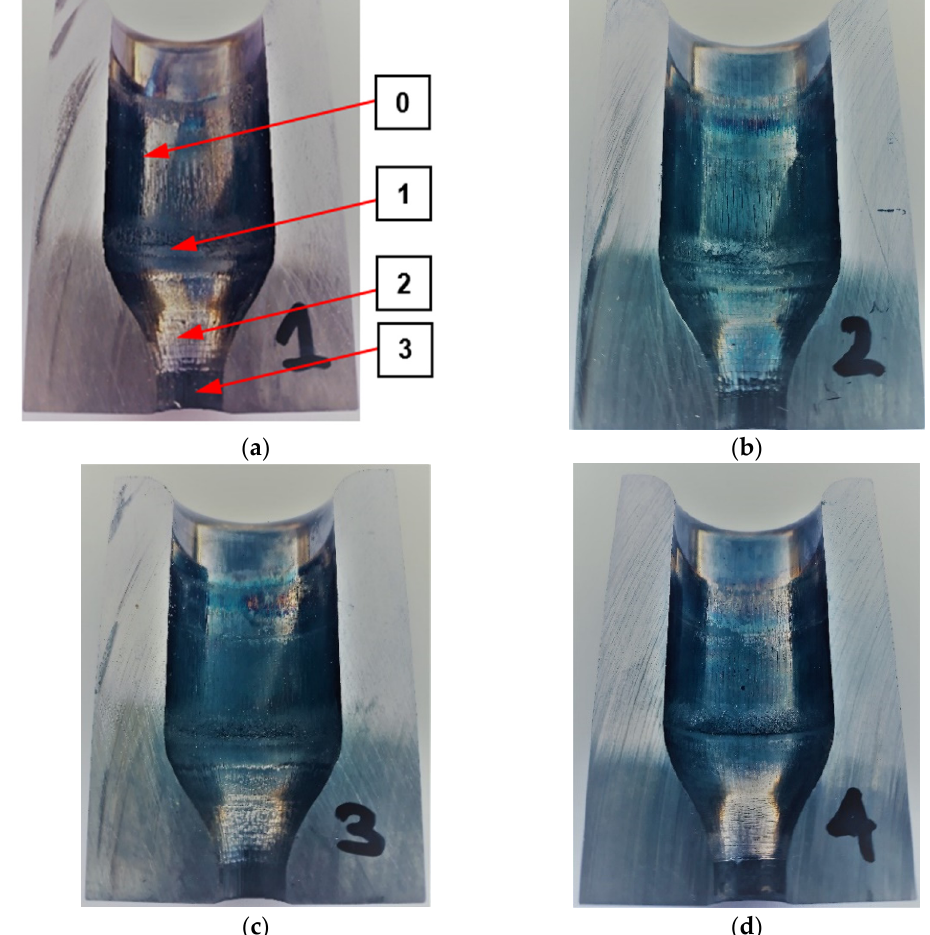
Figure 9. Macro photos of cut dies with marked all characteristic zones (in zone 0 the forging is not formed during 1st operation, zones 1-3 are involved in forming and wear, which affects the quality of the forging: ( a ) variant 1; ( b ) variant 2; ( c ) variant 3; ( d ) variant 4.